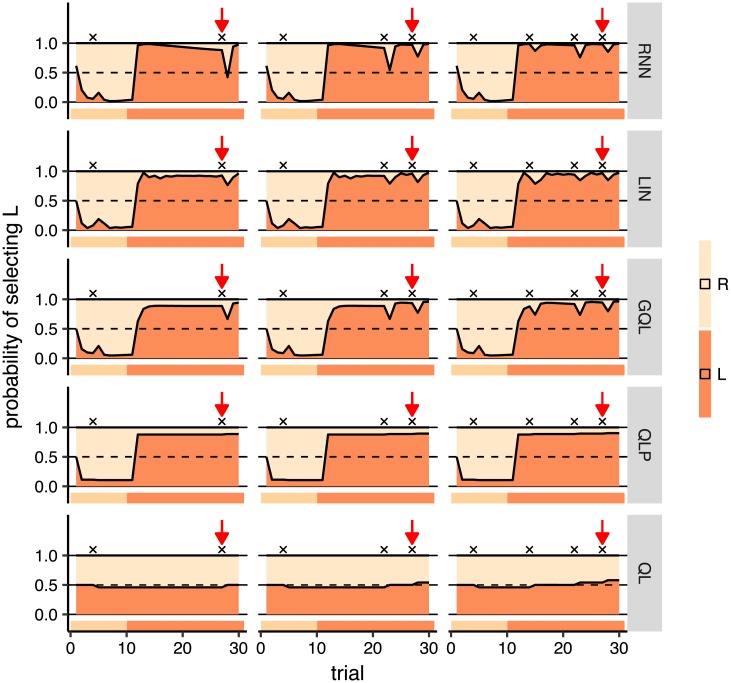
Off-policy simulations of all models for group healthy.Each panel shows a simulation of 30 trials (horizontal axis), and the vertical axis shows the predictions of each model on each trial. The ribbon below each panel shows the action which was fed to the model on each trial. In the first 10 trials, the action that the model received was R and in the next 20 trials it was L. Rewards are shown by black crosses (x) on the graphs. Red arrows point to the same trial number in all the simulations and are shown to compare changes in the predictions in that trial between different simulations. The sequence of rewards and actions fed to the model are the same for the panels in each column, but they are different across the columns. See text for the interpretation of the graph.